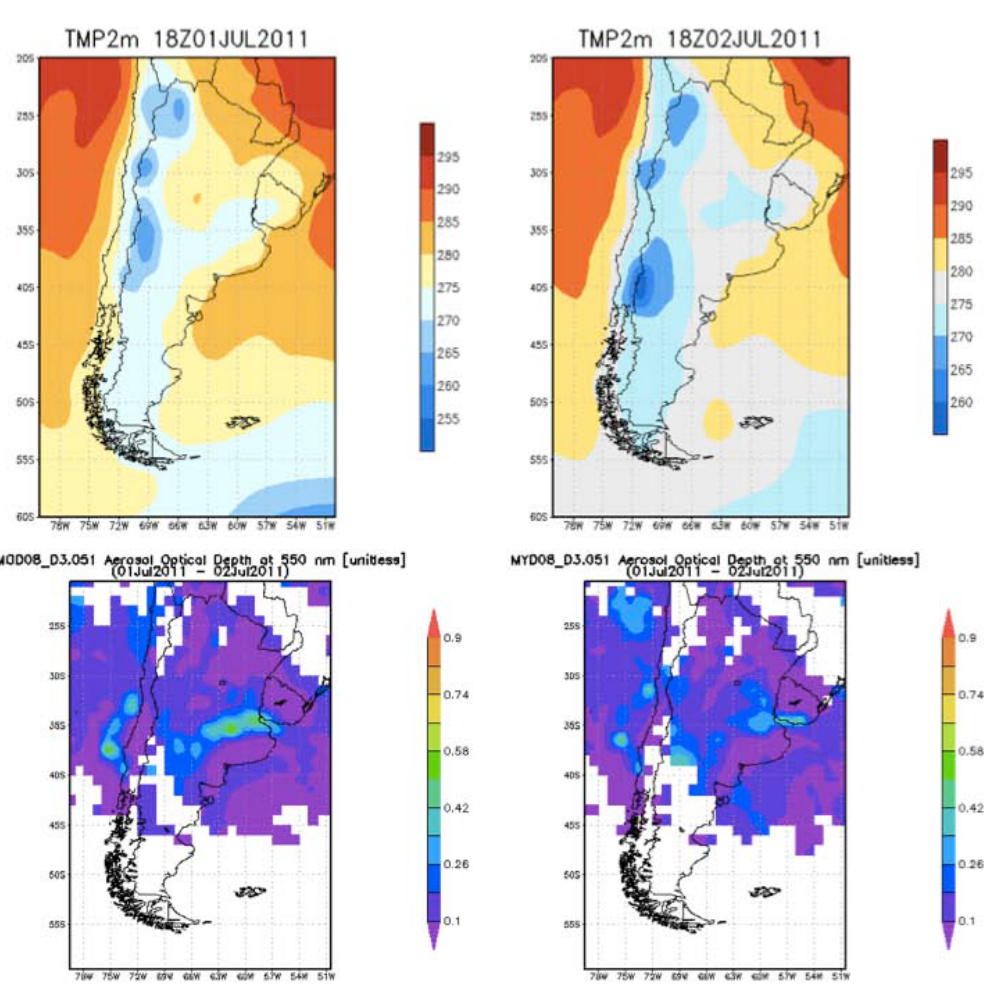
Fig. 5. Spatial distribution of the near surface temperature (K) at 18Z for 1 and 2 July 2011 (top panels). Spatial distribution of Aerosol Optical Thickness derived from MODIS for 1–2 July 2011, from Terra (bottom left panel) and Aqua (bottom right